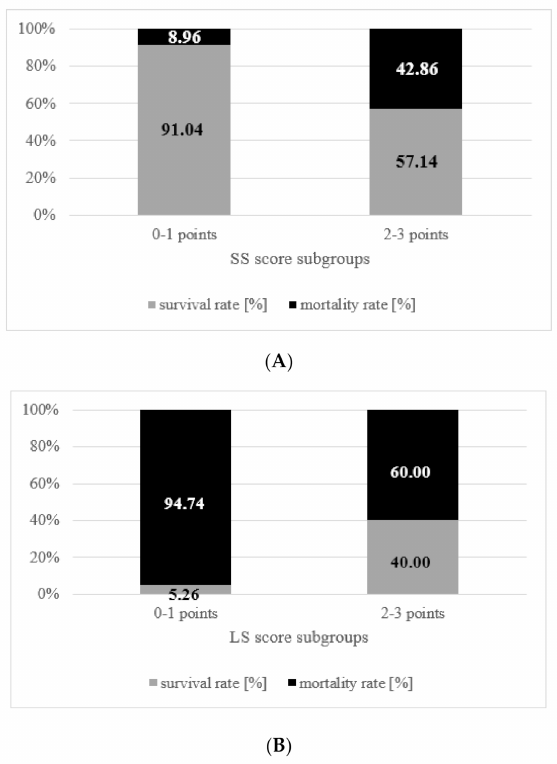
Figure 1. Bar charts showing the association between the SS- ( A )/LS- ( B ) scores and the survival rates at appropriate timepoints (6 months and 3 years for the SS- and LS-scores, respectively). The outcomes were reported for each score after the dichotomization into low (0–1 points) and high (2–3 points) score